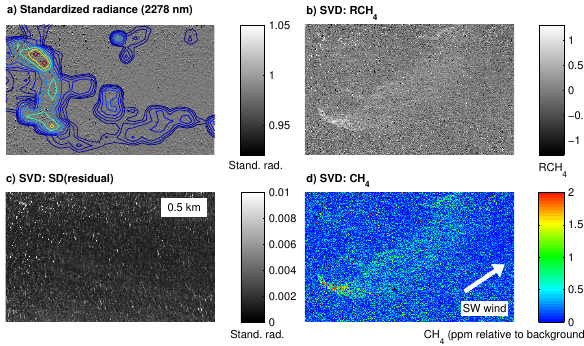
Fig. 11. (a) Standardized radiance used for calculating SVD at COP (showing only 2278nm). (b) For the same image subset, RCH 4 re- sults clearly indicate CH 4 plume. (c) The standard deviation of the residuals (measured minus modeled radiance). (d) ppm CH 4 rela- tive to background, excluding pixels with greater than 0.0075 stan- dard deviation of the residual (a unitless value given the SVD was performed on standardized